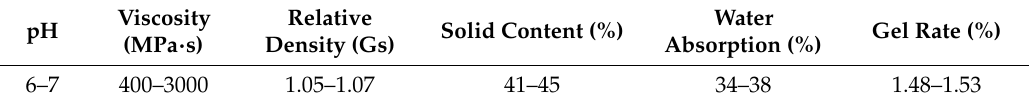
Figure 1. Vinyl acetate polymer. Table 1. The basic physical and chemical properties of vinyl acetate polymer.